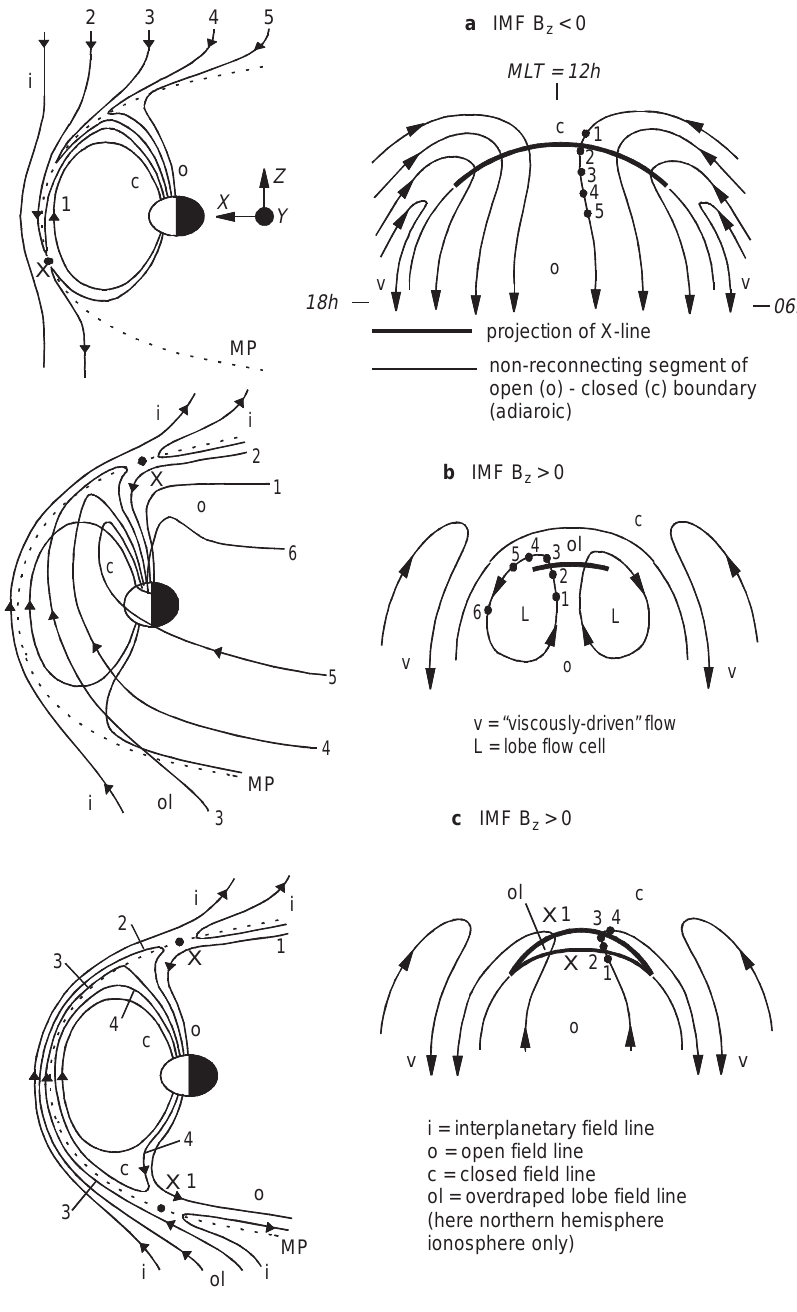
Fig. 1a–c. Schematic illustrations of ( left ) the evolution of reconnected field lines in the magnetosphere, as seen from the dusk flank and ( right ) the corresponding steady-state flow in the Northern Hemisphere ionosphere, with noon to the top. a is for southward IMF whereas b and c are two of the possibilities for northward IMF in all cases with B » 0. Field y lines and regions that are open, closed, interplanetary and overdraped lobe are lobe are labelled, respectively, o, c, i, and ol . See text for details (adapted from